Question: How would you classify this visualization?
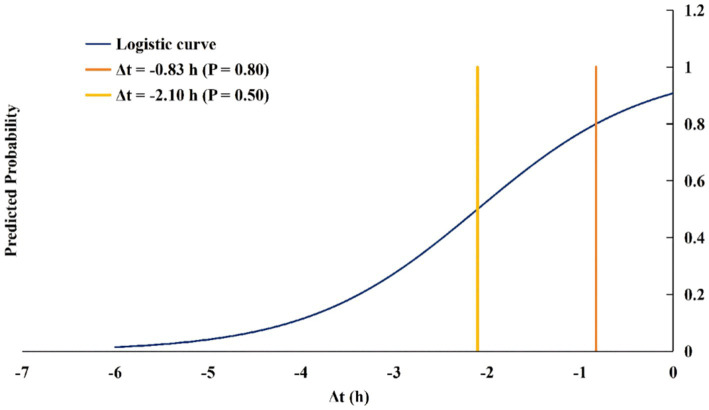
Answer: line